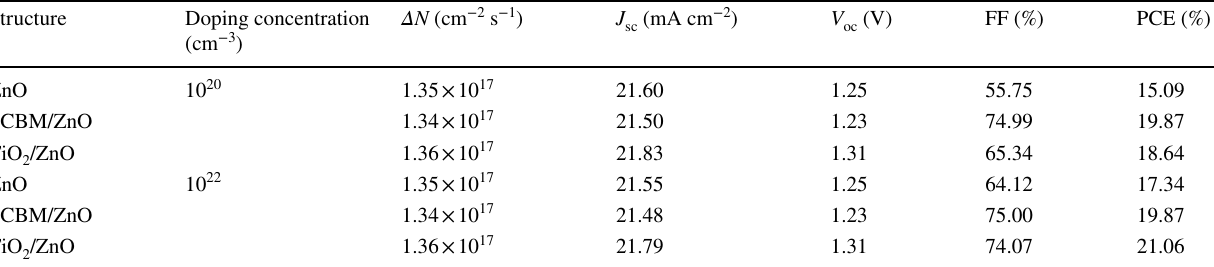
Table 2 Parameters of CsPbI 3 -based PSCs with a ZnO single-layer ETL, PCBM/ZnO bilayer ETL, and TiO 2 /ZnO bilayer ETL